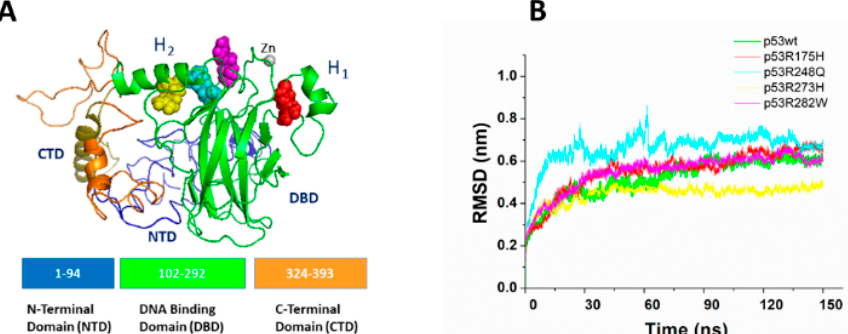
Figure 1. ( A ) Graphical representation of the best model for p53wt monomer. The residues submitted to a punctual mutation are represented as colored spheres: p53R175H (red), p53R248Q (cyan), p53R273H (yellow), and p53R282W (magenta). The Zn ion is represented as a light grey sphere. The various p53 domains are marked in different colors. ( B ) Temporal evolution of the RMSDs for all the p53 systems.